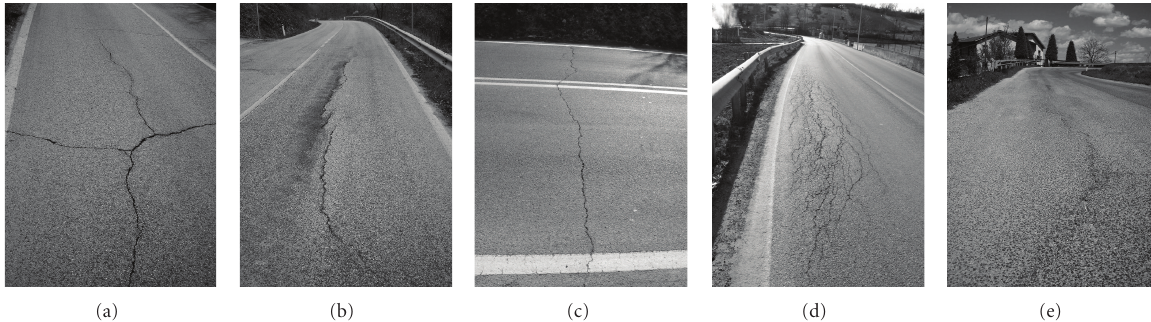
Figure 1: Structural defects investigated in this study: (a) longitudinal and transverse cracks, (b) longitudinal cracks only, (c) transverse cracks only, (d) ramified cracks, and (e) failures. The half road pavement is about 3m.